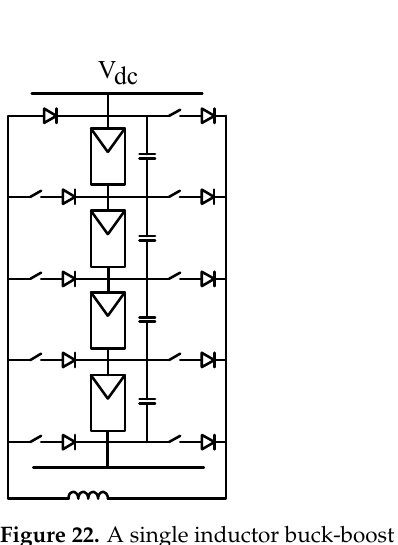
( c ) Figure 21. Differential power processing schemes: buck based ( a ); buck-boost based ( b ); flyback based ( c ) [45].